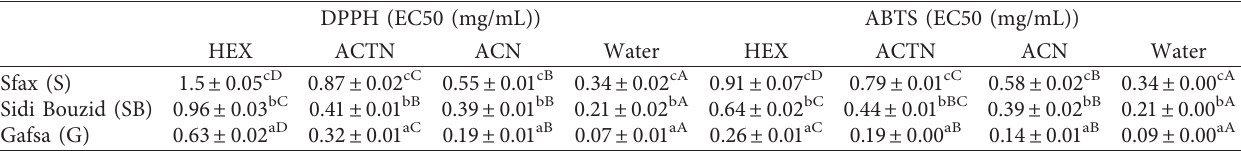
Table 3: Antioxidant activity of pistachio hull samples extracted by hexane, acetonitrile, acetone, and